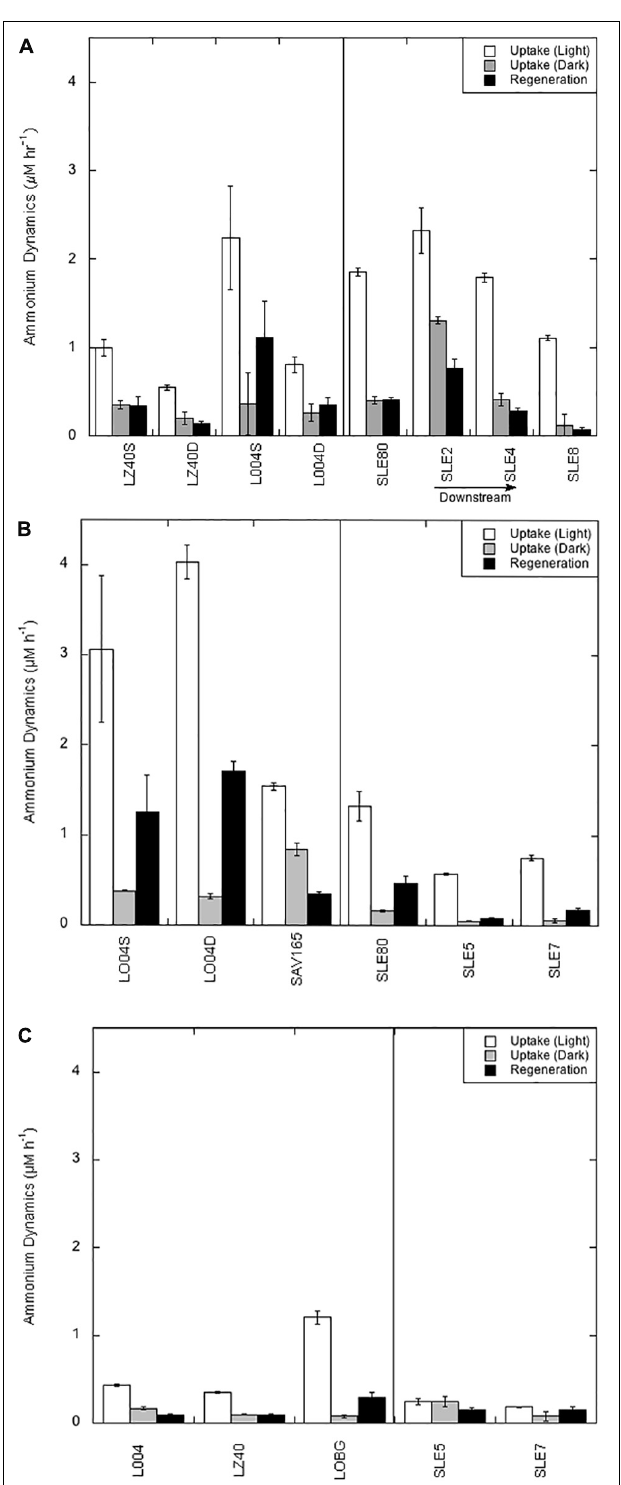
FIGURE 2 | Ammonium regeneration and potential uptake rates in Lake Okeechobee and St. Lucie Estuary in July 2016 (A) , August 2017 (B) , and September 2017 (C) . Values are averaged (three replicates) with error bars showing ± one standard error. Vertical line divides stations in the lake from stations in the estuary. S = surface water; D = bottom